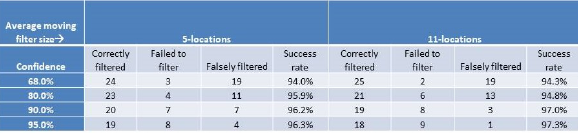
Figure 21. Filtering result at varying confidence intervals.